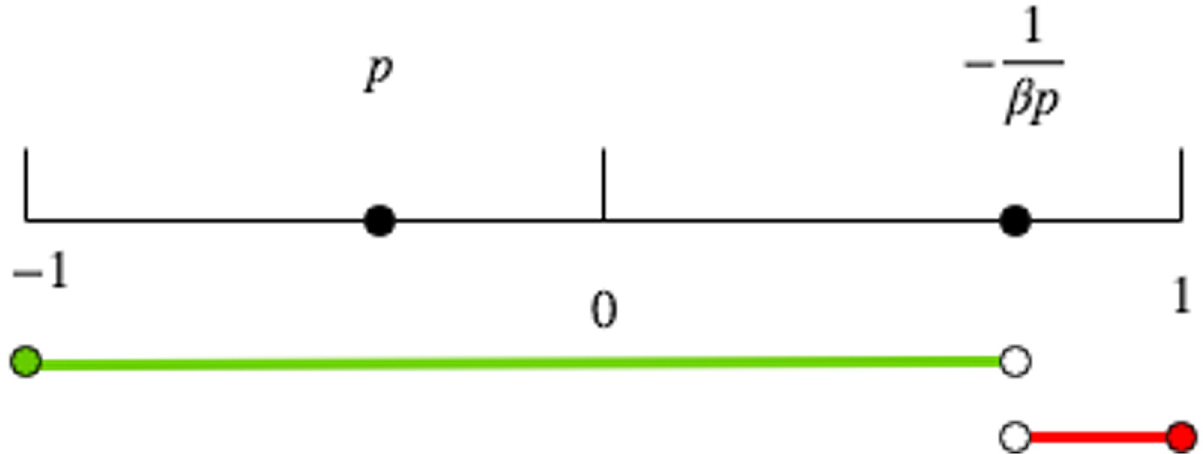
Fig 3. Graphical illustration of Case 2 from Theorem 1 (i.e. p < 0 and β � − 1/ p ). (a) For values of y ( t ) in the green range, y ( t ) will converge to y = p . (b) For values of y ( t ) in the red range, y ( t ) will diverge to y = 1. (c) For y ð t Þ ¼ (cid:0) 1